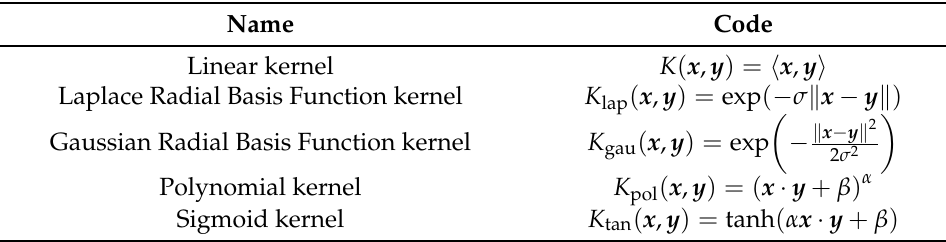
Table 1. Commonly used kernel